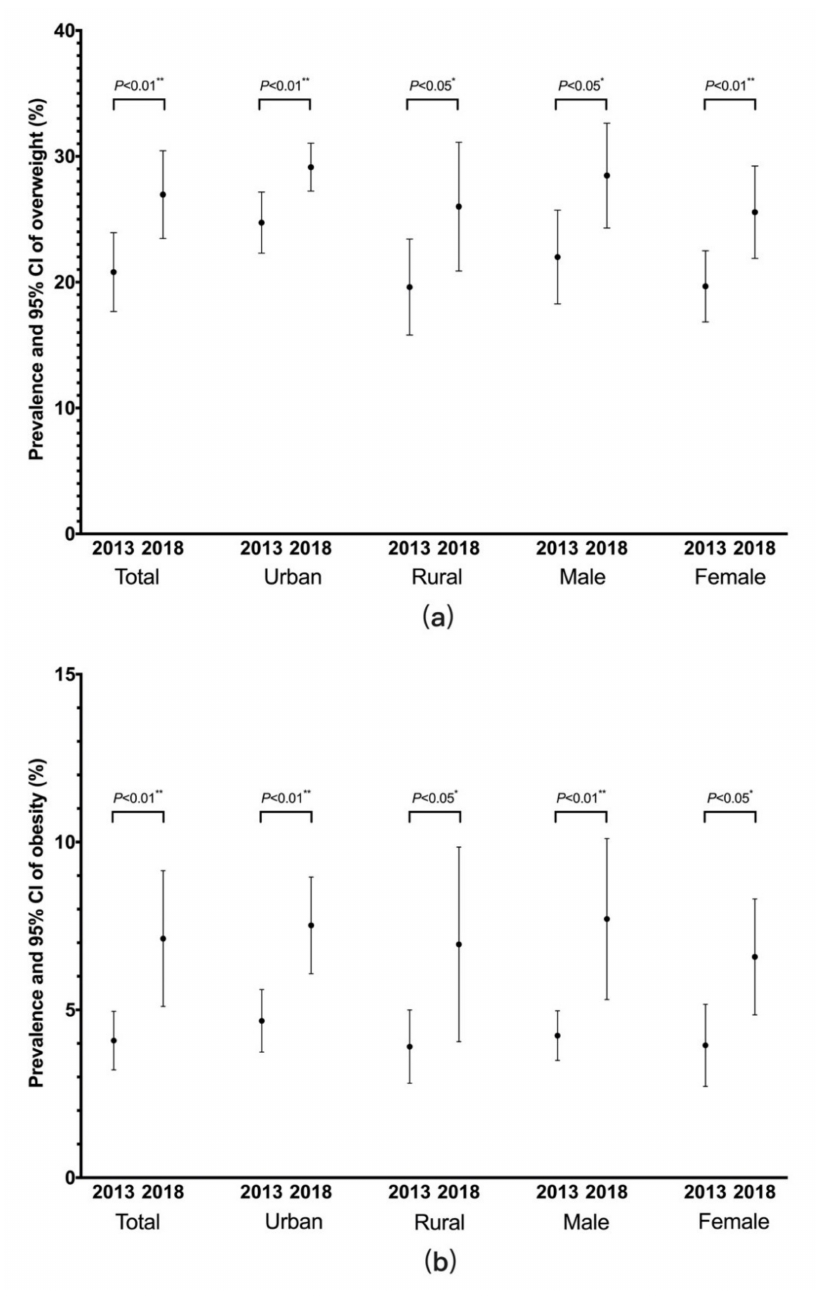
Figure 2. ( a ) Prevalence rates of overweight among inhabitants aged 18 years and older between 2013 and 2018 by place and sex in Hunan Province, China; ( b ) Prevalence rates of obesity among inhabitants aged 18 years and older between 2013 and 2018 by place and sex in Hunan Province, China. 95% CI: 95% confidence